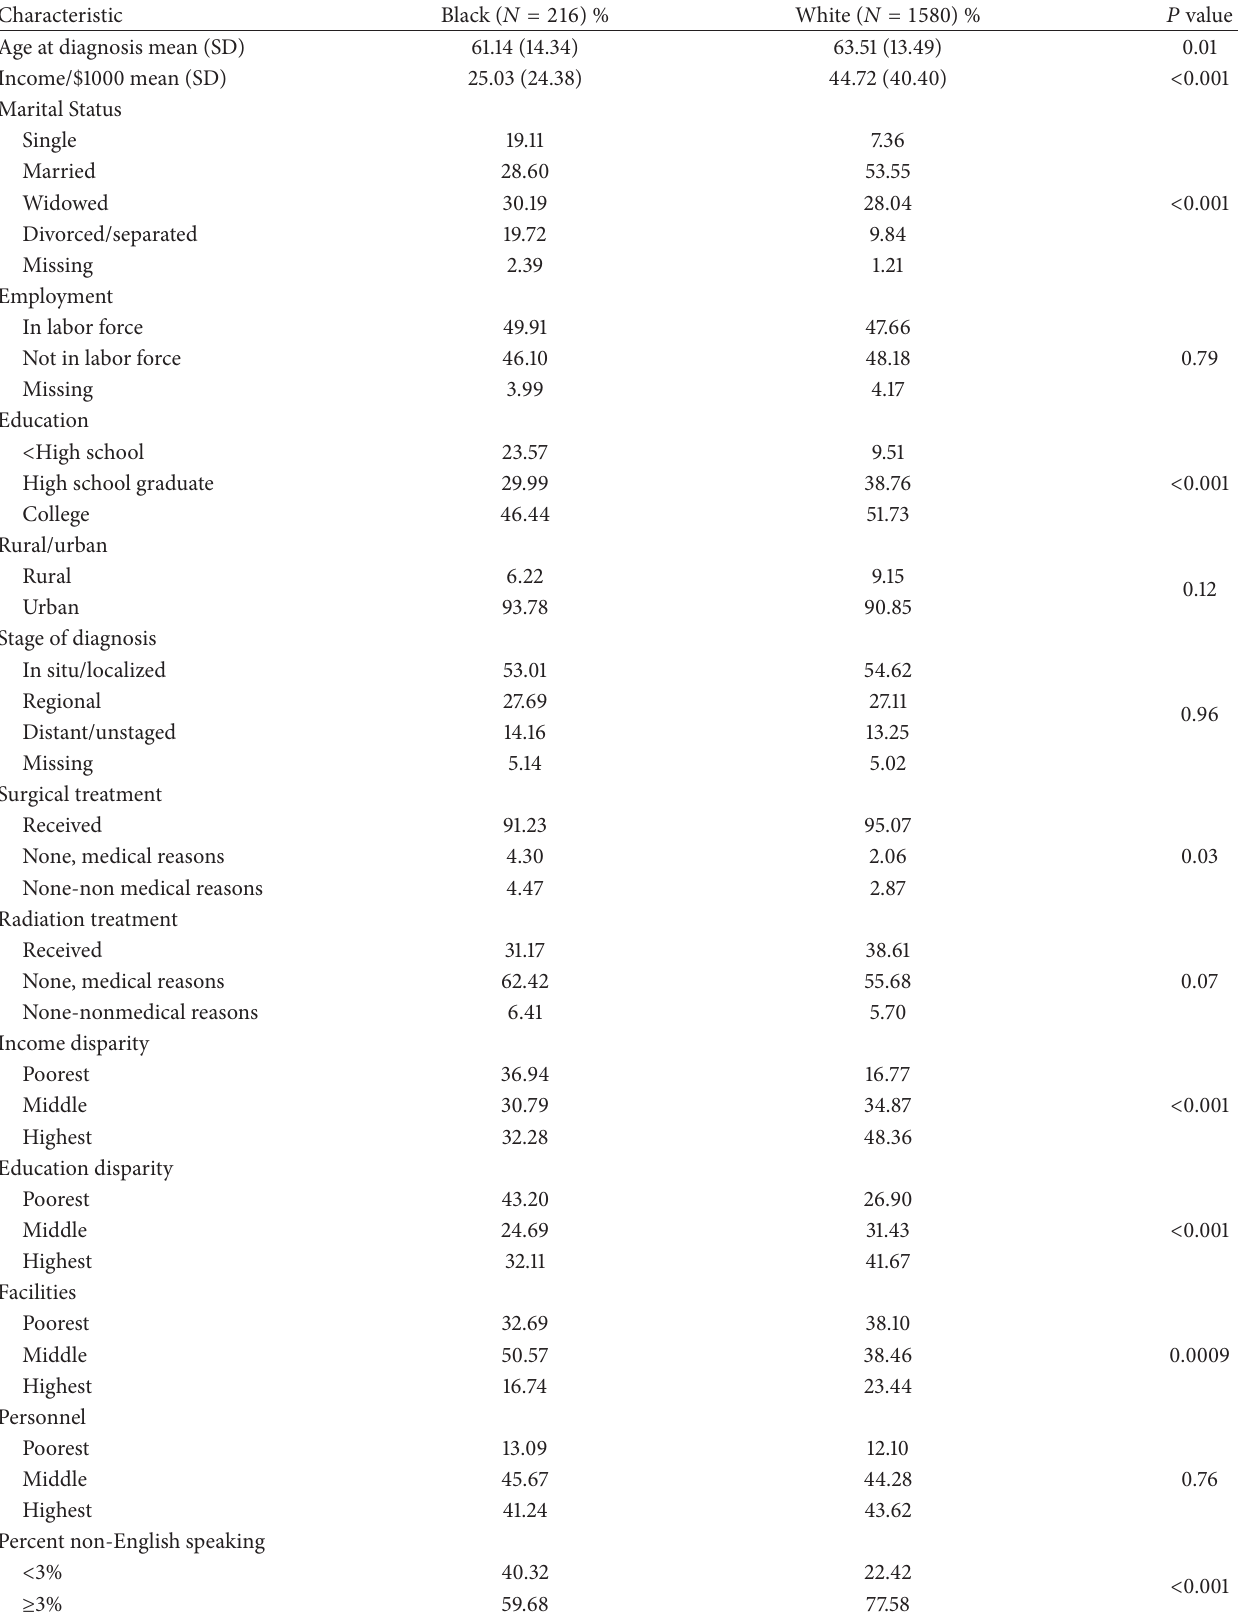
Table 2: Distribution of individual and county-level characteristics of breast cancer cases by